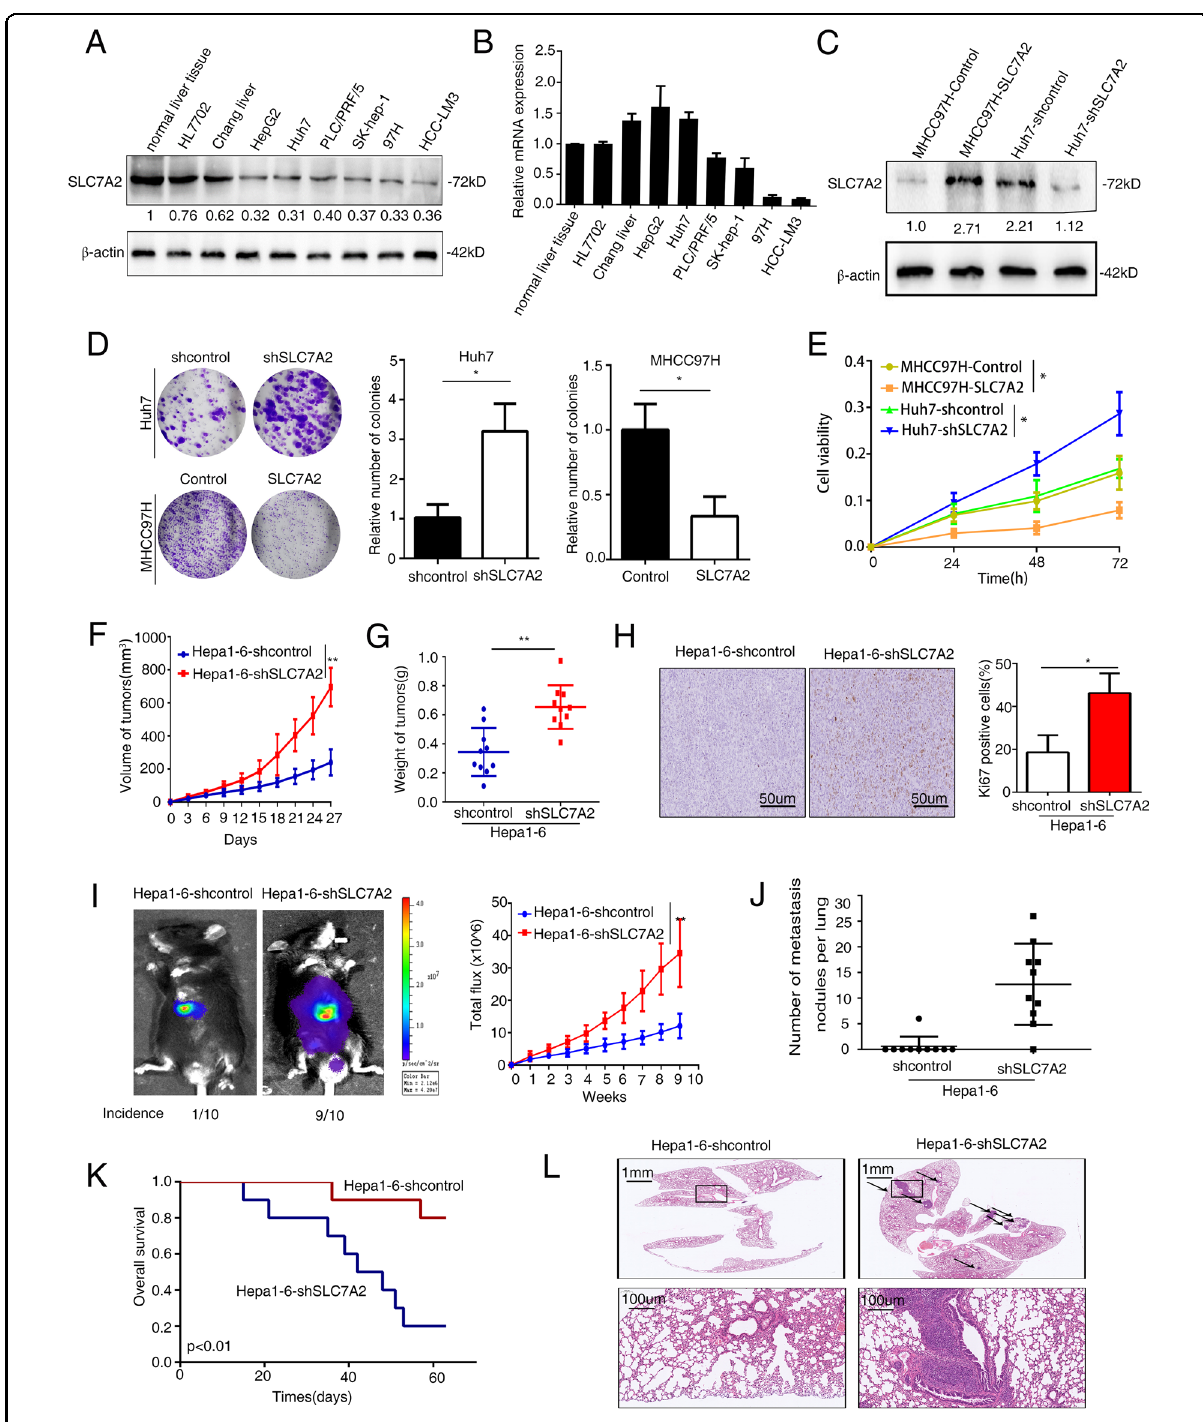
Fig. 2 SLC7A2 disruption facilitates HCC proliferation, invasion, and metastasis in vitro and vivo. A , B Relative mRNA and protein expression of SLC7A2 in normal liver tissue and HCC cell lines. C Western blotting analyzed performed the expression of SLC7A2 in Huh7 and MHCC97H cells after lentivirus transfection. D , E De fi cient SLC7A2 promoted HCC cell proliferation in vitro. D Effects of SLC7A2 on HCC cell colony formation. E The effects of SLC7A2 on HCC cell proliferation were measured by a CCK-8 assay. The data are shown as the mean ± SD from the at least three independent experiments; * P < 0.05. F – L De fi cient SLC7A2 promoted HCC cell growth and migration in vivo. F Growth curves and G weight curves of tumors in C57BL/6 ( n = 10 mice per group) in subcutaneously model. H IHC staining for Ki67 in the indicated tumors. I Representative Bioluminescent images and total photon fl ux were shown. J Incidence of lung metastasis and the number of metastatic nodules in the different group. K Overall survival time in C57BL/6 mice. L Representative images of H&E stained-lung tissues from the different. The scale bars represent 1 mm (upper panel) and 100 μ m (lower panel). The data are shown as the mean ± SD; * P < 0.05, ** P <